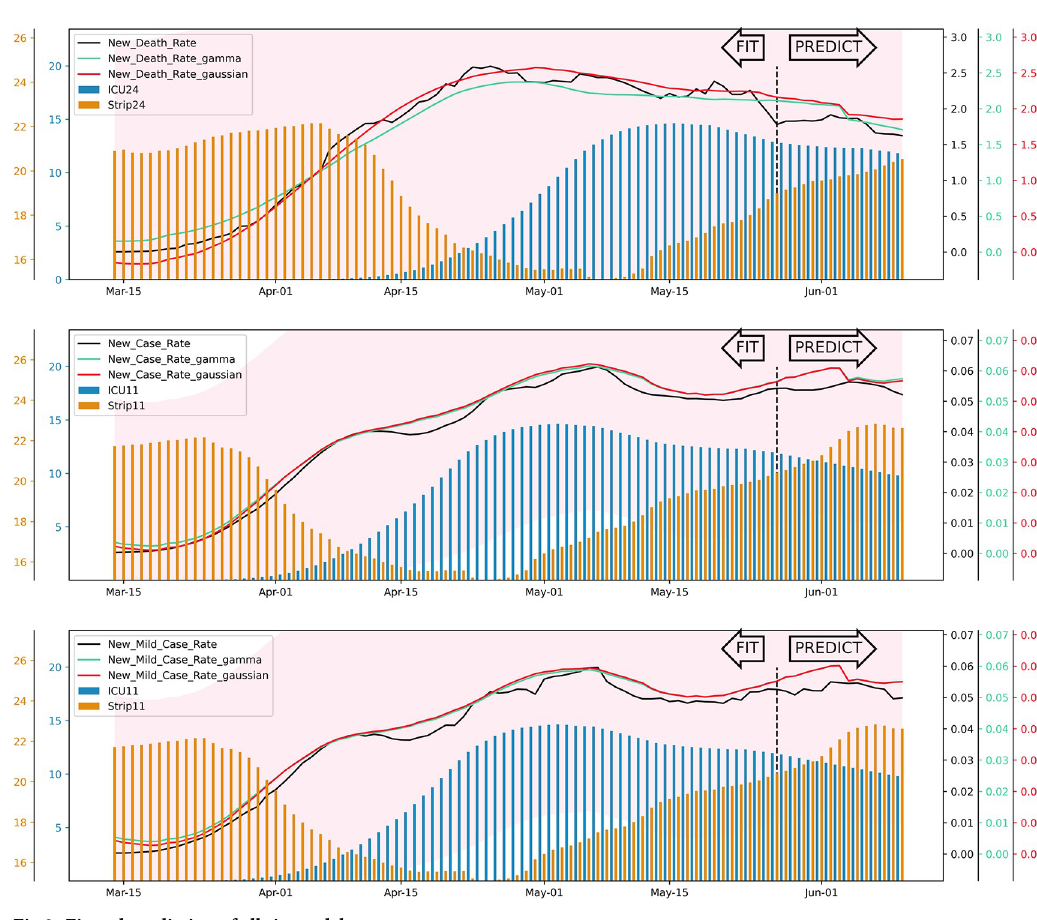
Fig 2. Fit and prediction of all six